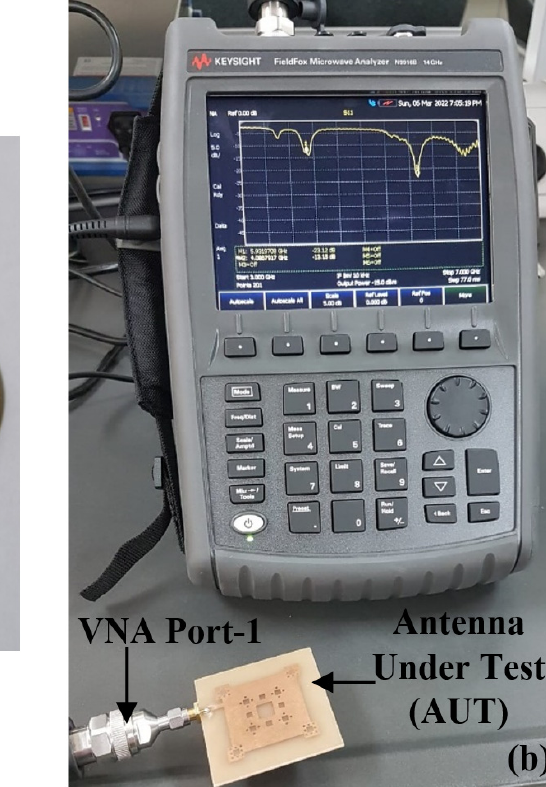
Figure 5. Simulated E − plane 2D radiation pattern of single-element antenna using ( a ) FR4 and ( b ) TMM4 substrates at 4.17 and 5.97 GHz, respectively, and simulated H − plane 2D radiation pattern of single − element antenna using ( c ) FR4 and ( d ) TMM4 substrates at 4.17 and 5.97 GHz, respectively.